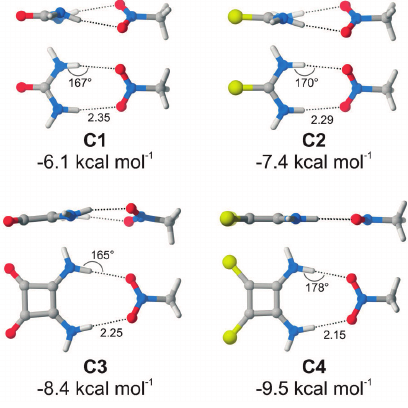
Figure 18. Four complexes C1 – C4 of (thio)ureas and (thio)squaramides with nitromethane. Adapted with permission from Ref. [50]. Copyright (2013) John Wiley and